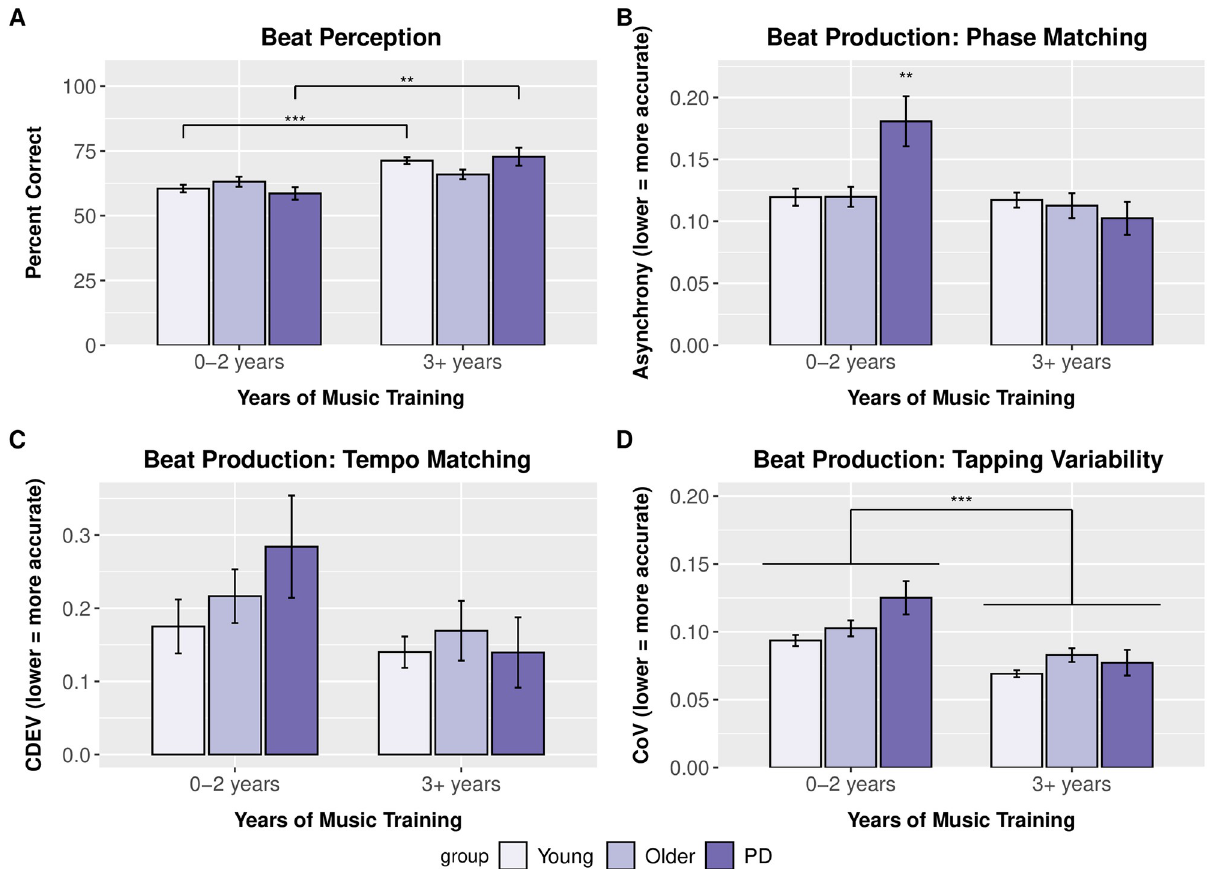
Fig 1. Music training effects on beat perception and production. Performance broken down by group (young, older, Parkinson’s disease) and music training (0–2 years, 3+ years) for beat perception (A), beat production phase matching (B), beat production tempo matching (C), and beat production tapping variability (D). For beat perception, young adults and Parkinson’s disease patients with more extensive music training were significantly better than those without. For asynchrony (phase matching), Parkinson’s disease patients with minimal music training were significantly worse than all other groups. No significant differences were present for coefficient of deviation (tempo matching). For coefficient of variation (tapping variability), older adults and Parkinson’s patients were more variable than younger adults, and participants with more extensive music training (regardless of group) were less variable than those with little training. Error bars indicate the standard error of the mean. �� = p < .01, ��� = p < .001.